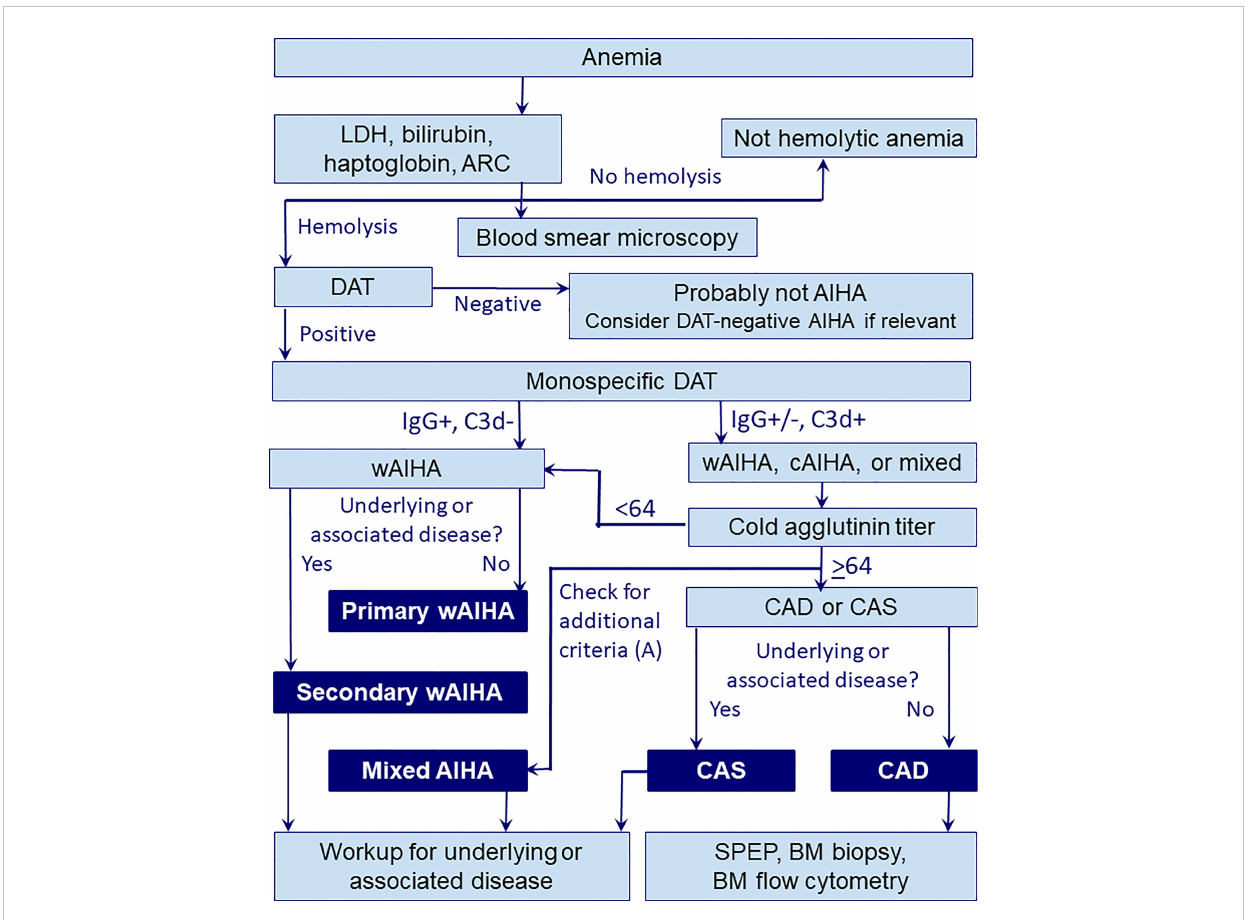
FIGURE 1 Diagnostic workup in AIHA. A, additional criteria for mixed AIHA (DAT strongly positive for both IgG and C3d, cold agglutinin titer ≥ 64, indirect antiglobulin test positive for IgG at 37°C); ARC, absolute reticulocyte count; BM, bone marrow; CAD, cold agglutinin disease; cAIHA, cold-antibody autoimmune hemolytic anemia; CAS, cold agglutinin syndrome; DAT, direct antiglobulin test; LDH, lactate dehydrogenase; SPEP, serum protein electrophoresis; wAIHA, warm-antibody autoimmune hemolytic anemia.